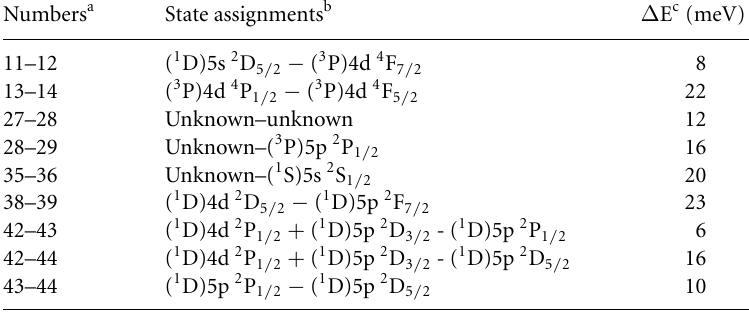
Table 1. Possible states involved in the quantum beat oscillations in the Kr 2 + ion yield obtained with HH21 (32.8 eV). Numbers